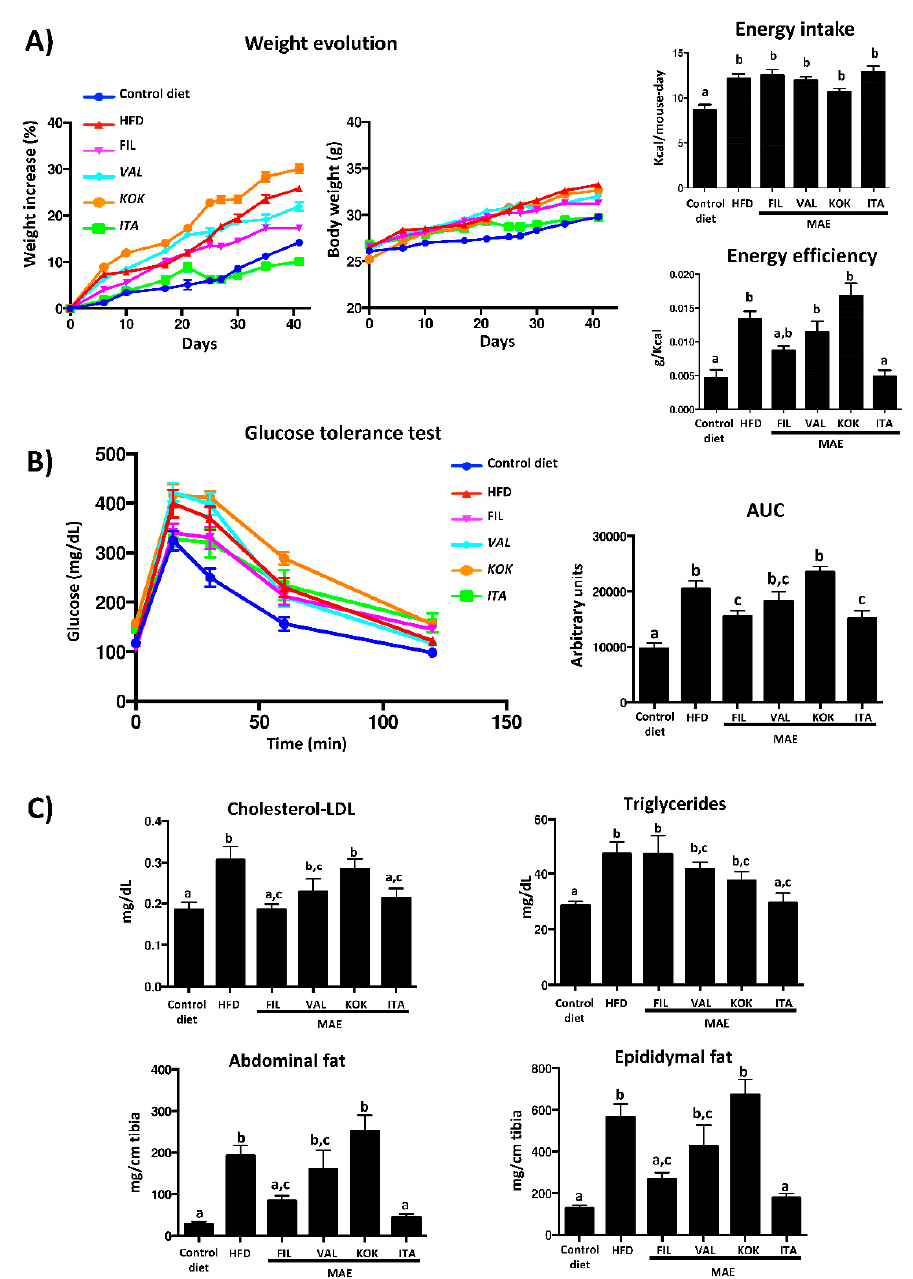
Figure 3. E ff ects of di ff erent Morus alba genotypes ( Filipina , Valenciana temprana , Kokuso , and Italia ) administration on ( A ) morphological changes (body weight evolution, energy e ffi ciency, and energy intake); ( B ) glucose tolerance test and area under the curve (AUC); and ( C ) cholesterol-LDL plasma levels, triglycerides, and epididymal and abdominal fat. Data are expressed as means ± SEM ( n = 10). Groups with di ff erent letters statistically di ff er ( p <